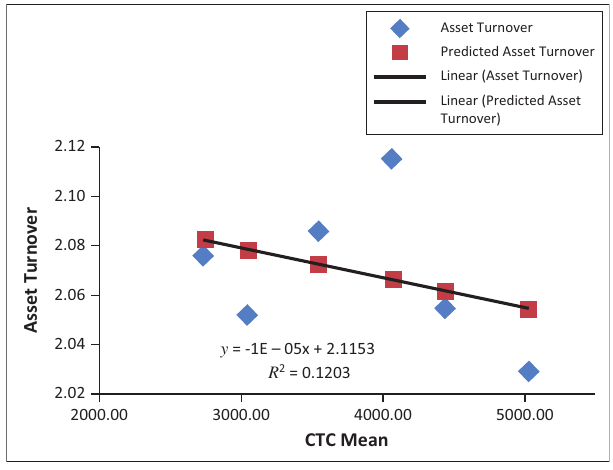
CTC, cost to company. FIGURE 11: Regression of asset turnover mean on cost to company mean.